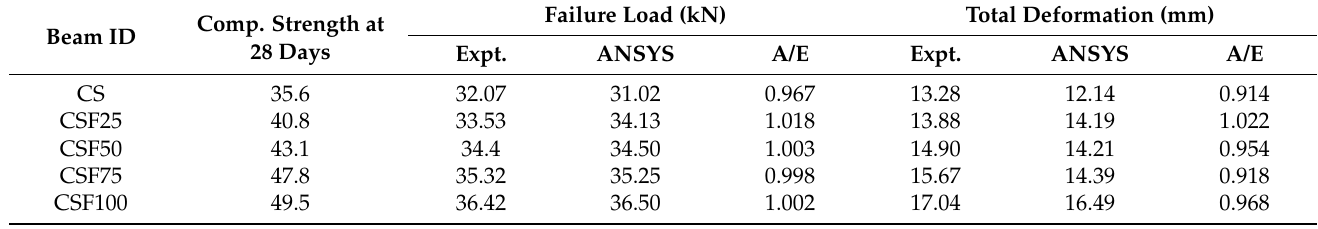
Table 8. The comparison of the ANSYS results with the experimental results.